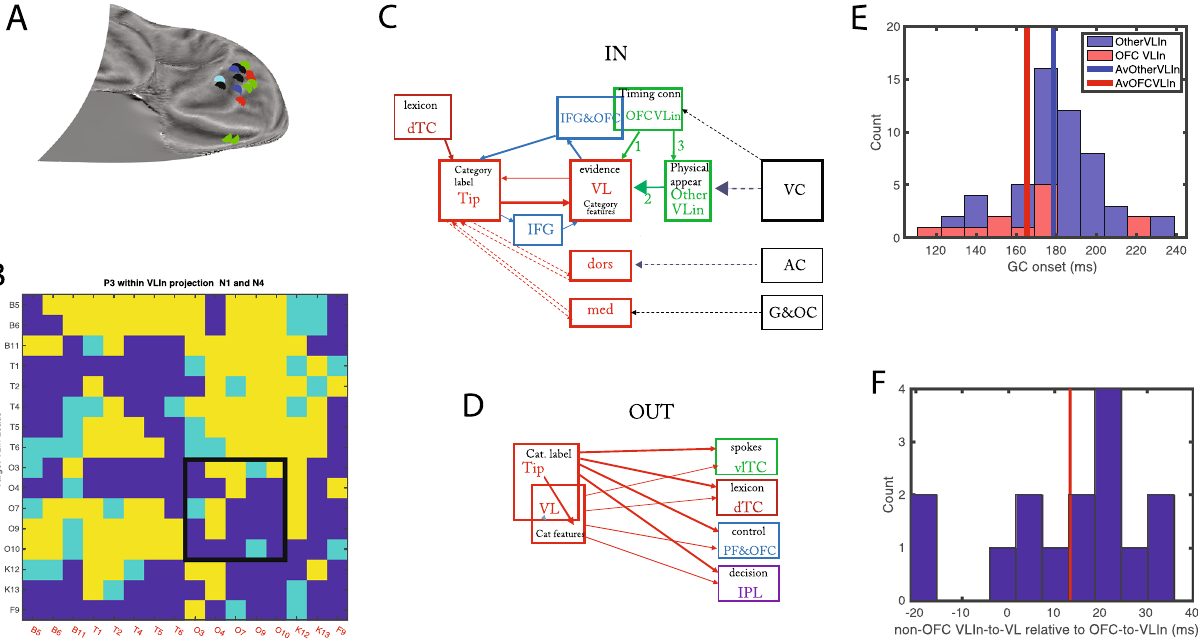
Figure 8. Relationship between intrinsic and outside functional connections. ( A ) location of OFC VLin leads in 5 patients (red: P1, light blue: P2, green: P3, black: P4, blue: P5) ( B ) matrix with connections between VLin leads in P3: yellow NS1 and/or NS4 uGC > 5, light blue: NS1 and/or NS4 uGC > 3 (but below 5), dark blue: both NS1 and NS4 uGC < 3; the two leads on the medial edge of OFC (O3, O4) combined are connected to all other VLin leads outside OFC (black square). ( C ) Scheme showing input functional connections to T. ( D ) Scheme with output functional connections T and VL combined; In C and D Red: TP subregions, green VLin leads, blue prefrontal and OFC, black: sensory cortices, Bordeaux: dorsal TC, purple: inferior parietal lobule; full lines: functional links inferred from present study with thickness indicating strength, stippled lines connections from literature. Black text hypothesized function. ( E ) distribution of onset latencies (mixed effect corrected) of VLin NS1 uGCs for OFC and other leads (arrows 1 and 2 in C). The two means are significantly different (mixed effects, see Suppl Text 14, p < 0.02). ( F ) difference between onset latencies of NS1 uGC from other non-OFC VLin leads to VL leads and from OFC VLin leads to other VLin leads (arrows 2 and 3 in C): the mean (13.3 ms) differs significantly from zero (mixed effects, see Suppl Text 15, p <